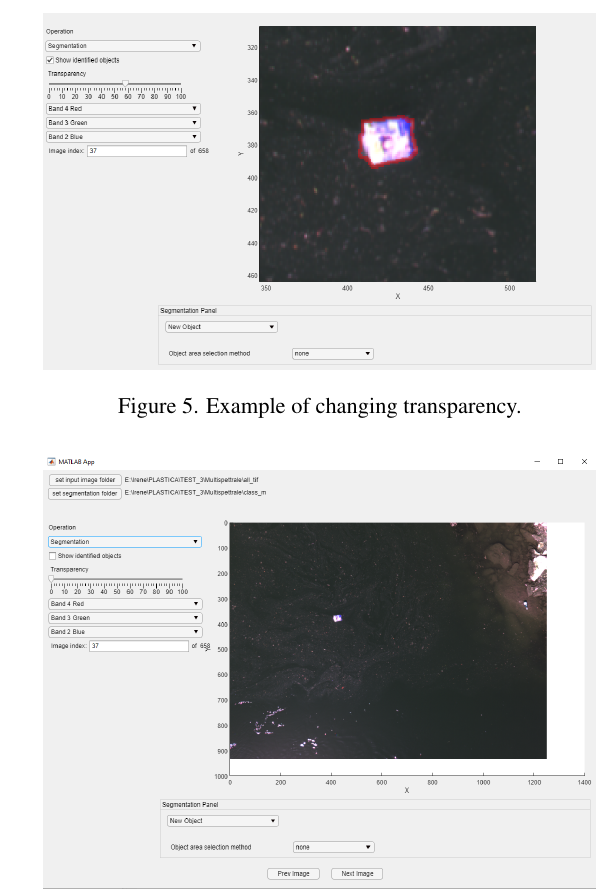
Figure 6. Graphical user interface window in Segmentation mode.